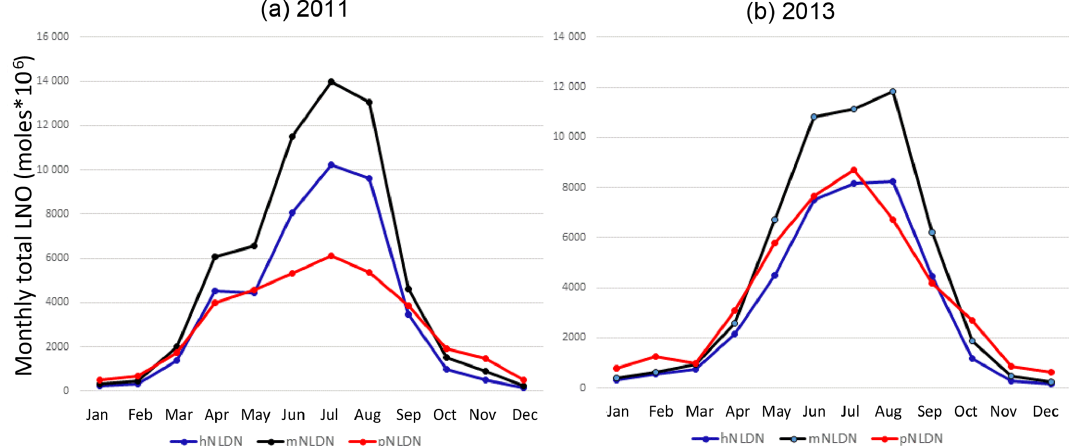
Figure 9. Total monthly column LNO over the model domain with different LNO production schemes for (a) 2011 and (b) 2013.